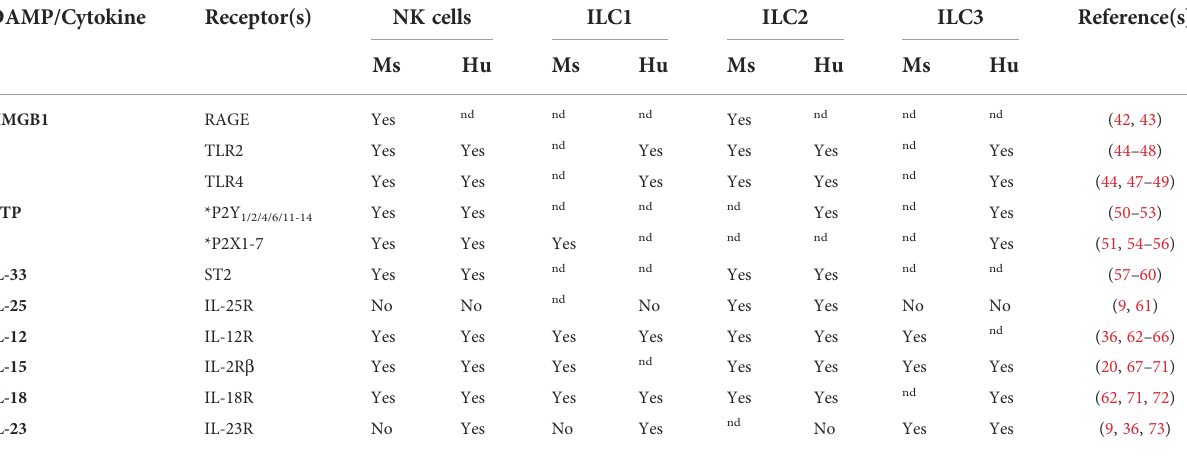
TABLE 1 Expression of DAMPs and cytokine receptors by